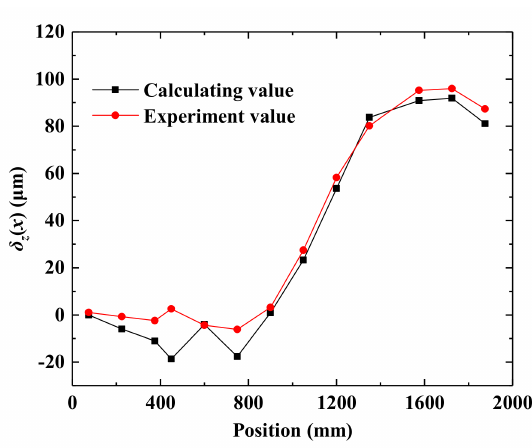
Figure 6. Results comparison of δ z ( x